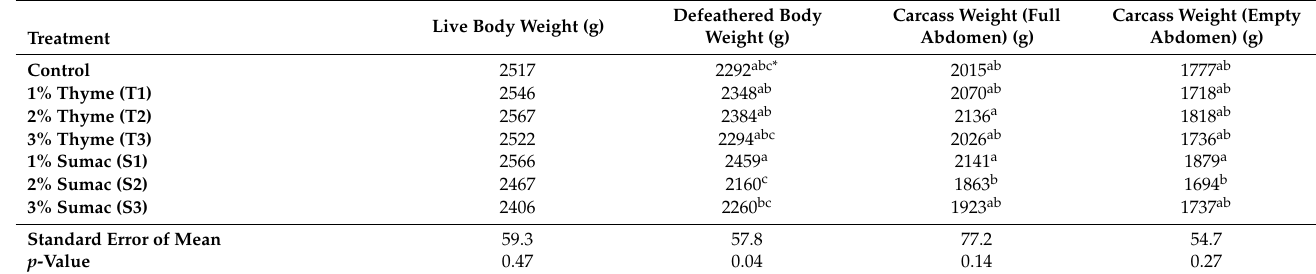
Table 3. Mean ( ± SEM) of economically relevant carcass characteristics at 42 days of age in Ross 308 broilers fed diets containing 0, 1, 2, and 3% thyme (T3) and sumac from days